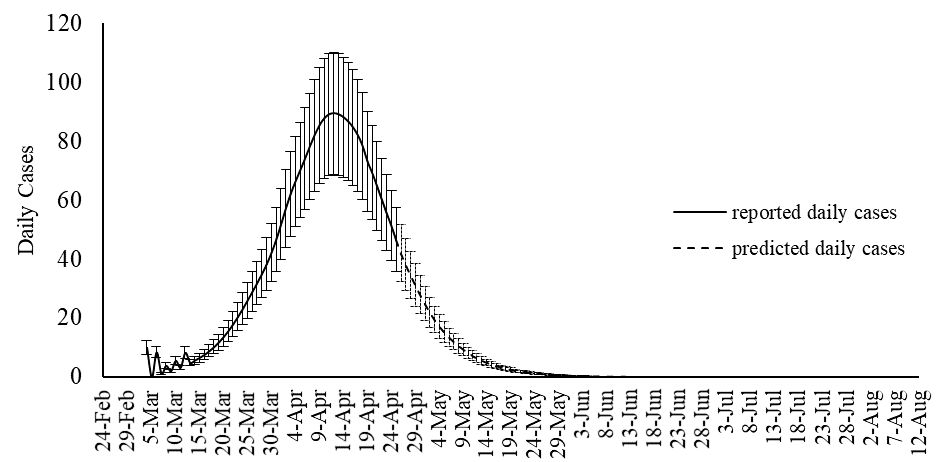
Figure 10. Daily outbreak prediction for MLP-ICA.